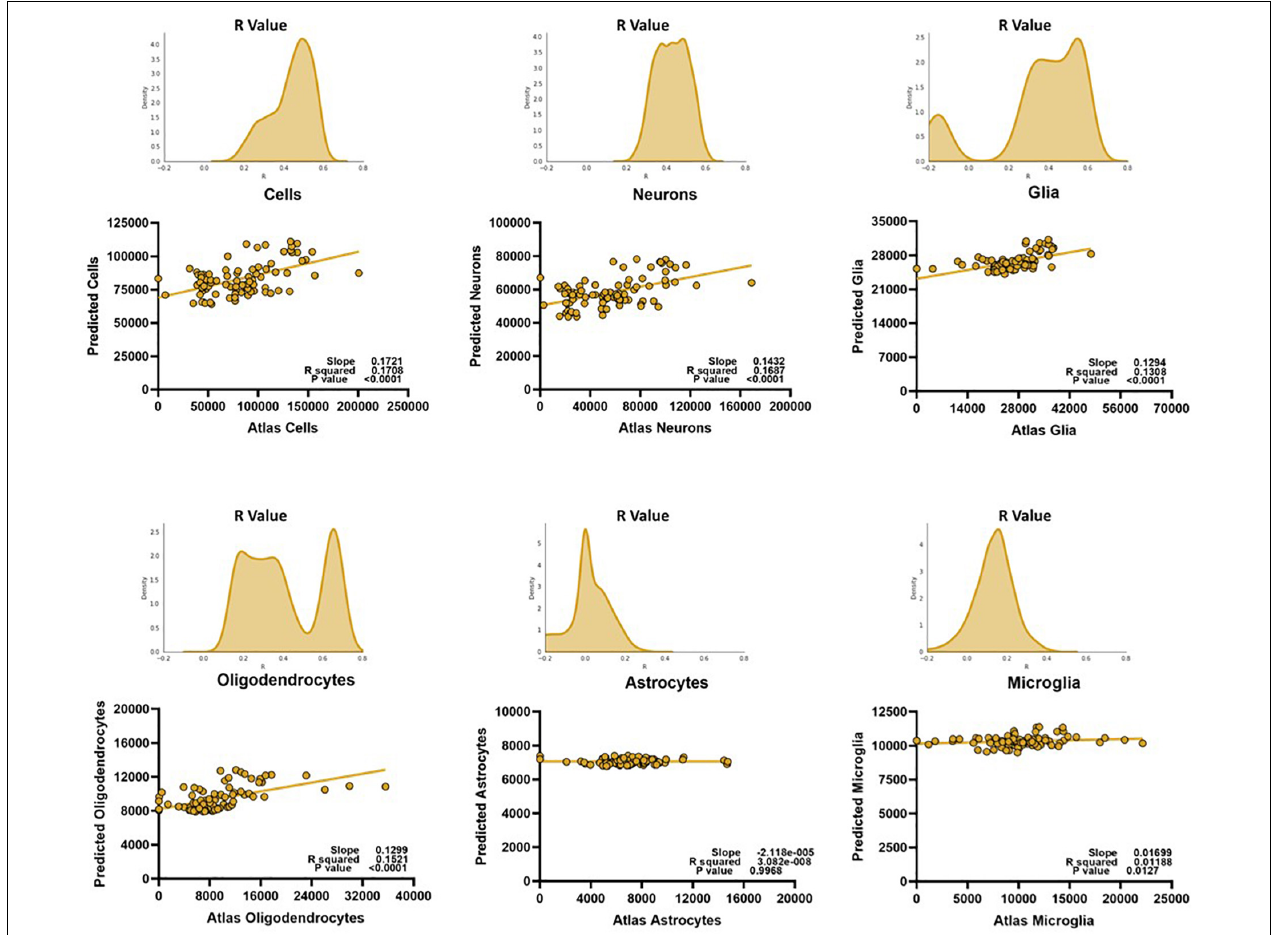
FIGURE 5 | The region-specific relationships can be exploited to create models that can successfully predict certain major cell types, but not glial subtypes like astrocytes and microglia. To prevent bias, the y -values on the linear regressions are from an average of the predicted values of each mouse for a given voxel, on a random trial. The histograms represent the distributions of the Pearson R value of the model when testing and training 1,000 samplings of 80% of the data, cross-validated on all mice. Predicted scale = 2 × atlas